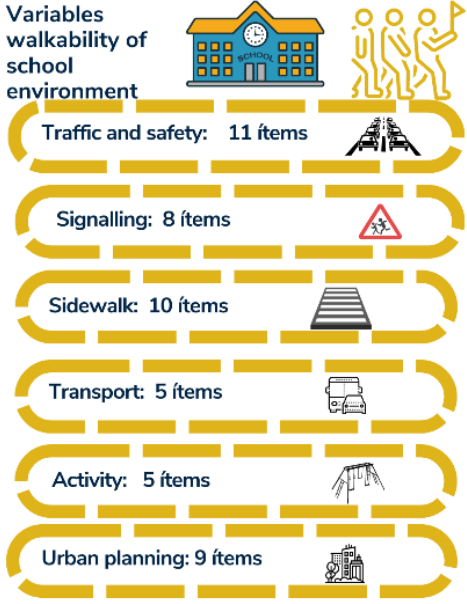
Figure 2. Variables of walkability of school